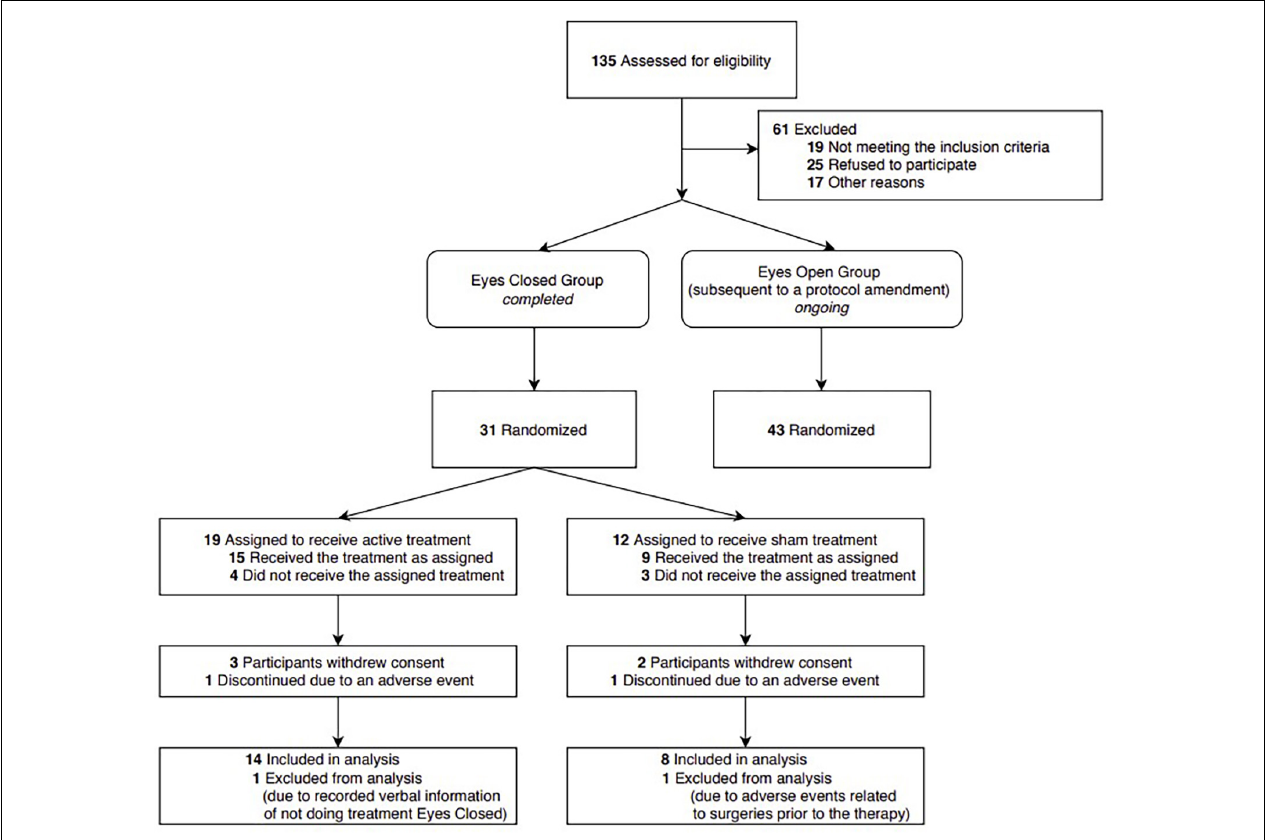
FIGURE 1 | CONSORT flow diagram and study design. Current analysis included patients receiving treatment during eyes-closed condition and completed the 6-month trial, including all patients in the treatment and sham groups. Patients not included in this report are currently receiving therapy during the eyes-open condition in the on-going